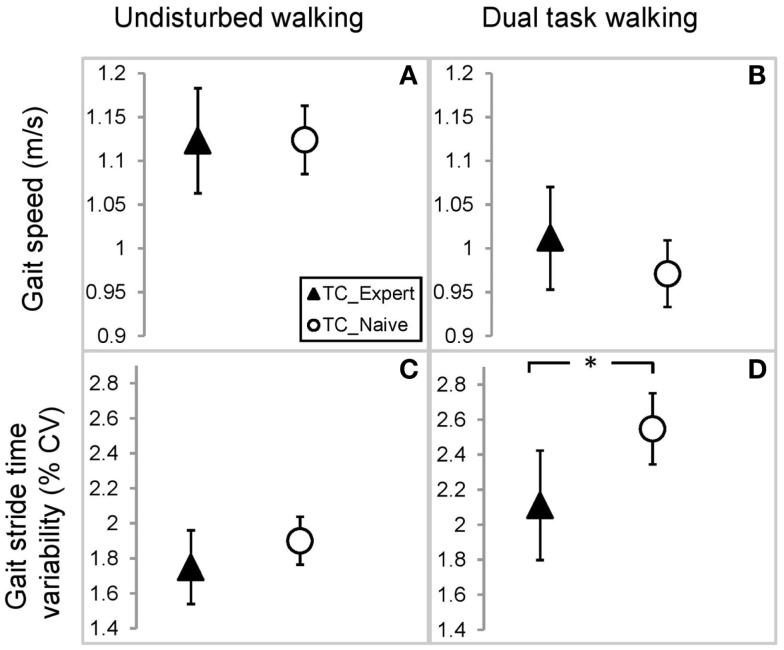
Comparison of gait parameters between Tai Chi expert and Tai Chi naïve older adults. Estimated mean and 95% confidence intervals for gait speed during undisturbed (A) and dual task walking (B), and gait stride time variability during undisturbed (C) and dual task walking (D). Values based on a linear mixed model accounting for variations in age, gender, BMI, and physical activity. *Indicates p < 0.05.